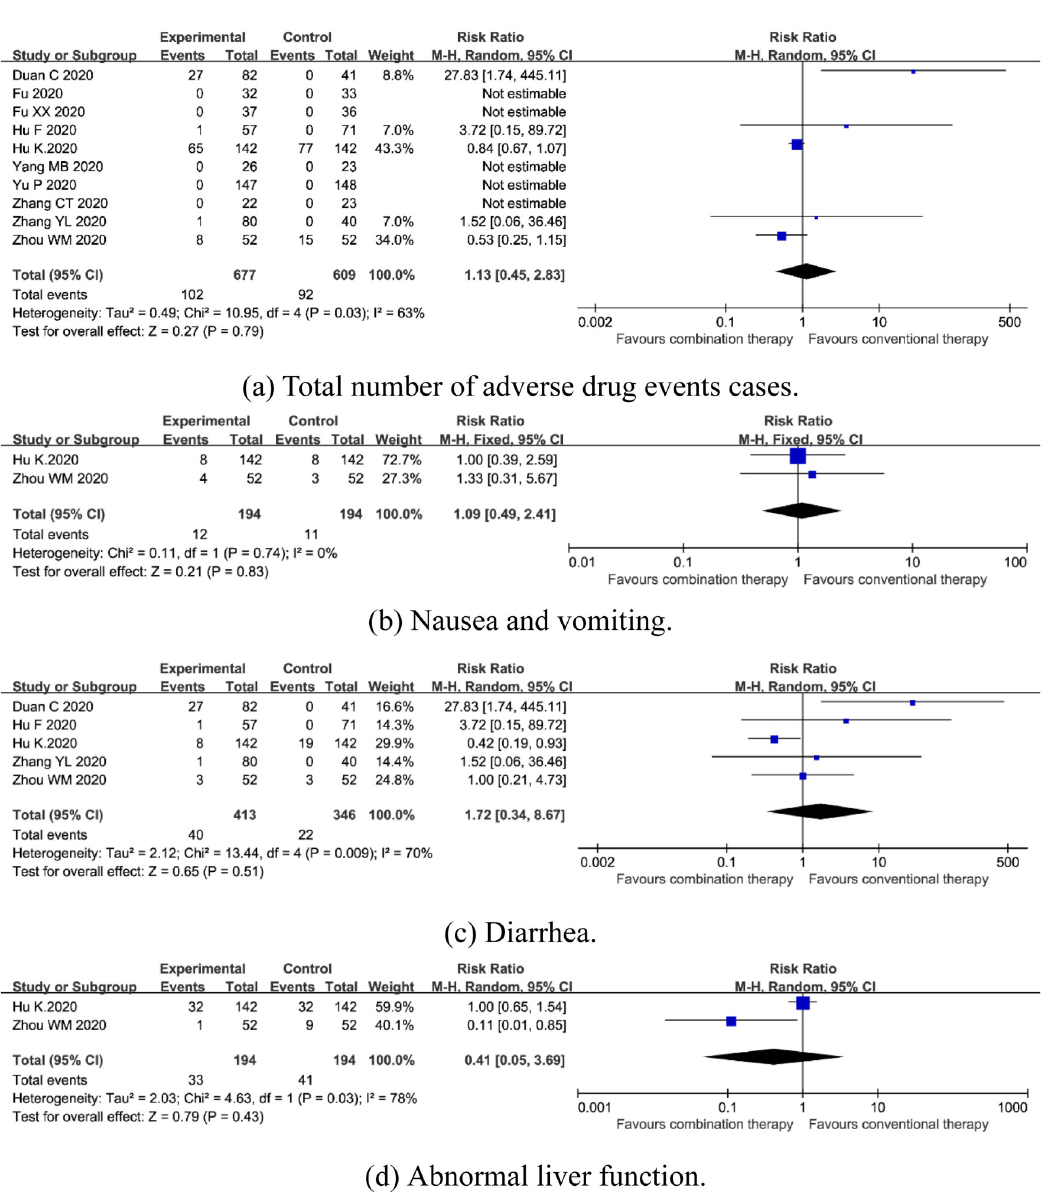
Fig 6. Forest plot of the safety of combination therapy for outcomes of (a) total number of adverse drug events cases, (b) nausea and vomiting, (c) diarrhea, (d) abnormal liver function.